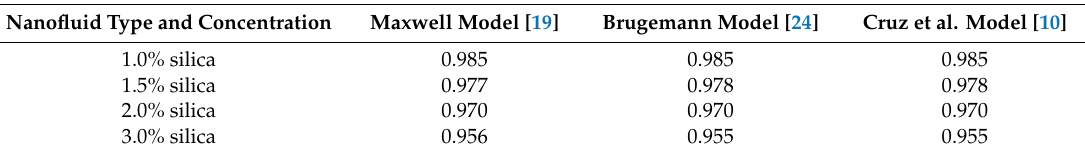
Table 3. Estimation of relative electrical conductivity using the Brugemann and Cruz models versus the Maxwell model for silica–water